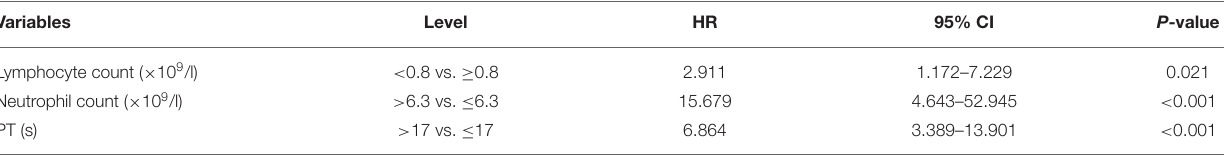
TABLE 2 | Risk factors of fatal outcome in the multivariate cox proportional hazards regression model.